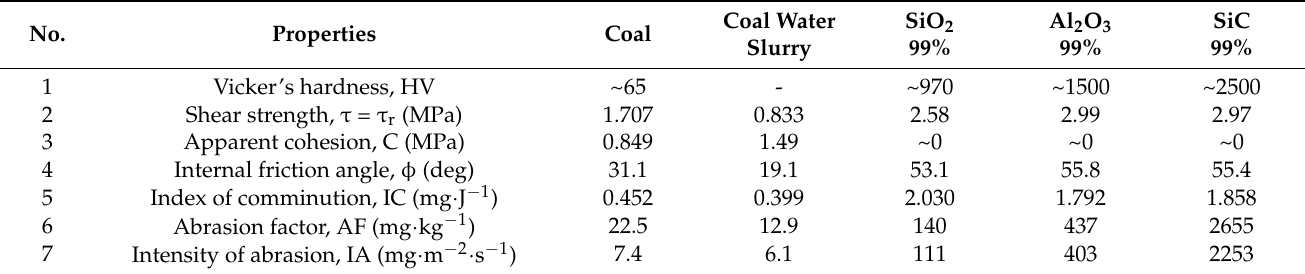
Figure 13. Scatter diagram of the results showing the relationship between Abrasion Factor (AF), tested with blade No. 1, and combined weight percentage of quartz and pyrite (R 2 = 0.0279). Table 3. Basic mechanical properties of selected coal, coal water slurry and abradants.